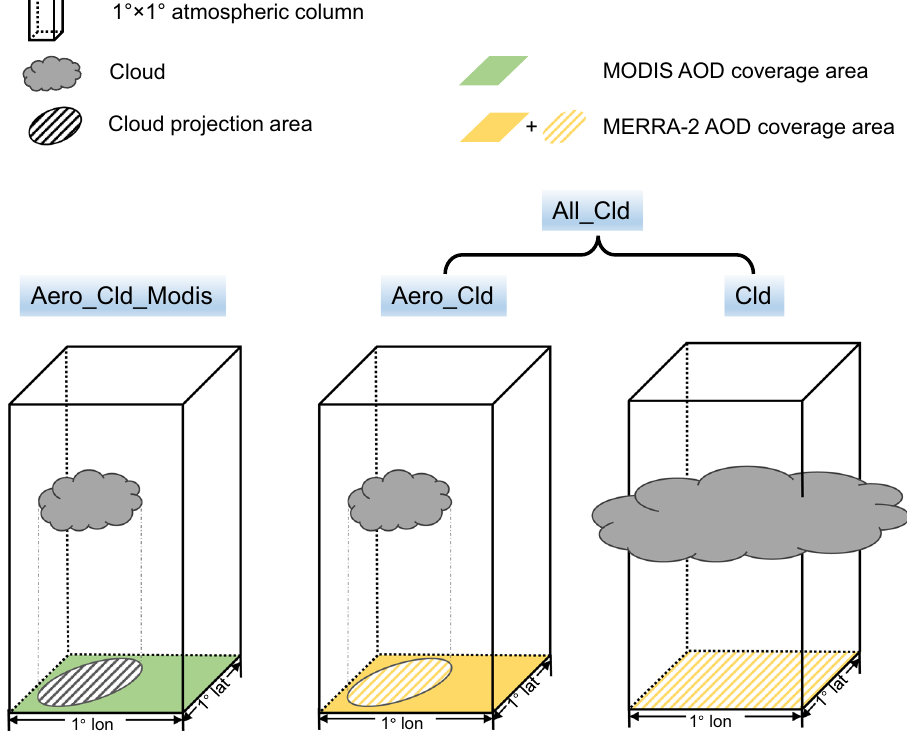
Fig. 1 Schematic diagram of four basic scenarios in this study. The schematic shows the combinations of clouds and its associated aerosol retrieval (green; MODIS aerosol optical depth (AOD))/reanalysis (yellow; MERRA-2 AOD) within 1° × 1° atmospheric column (cuboid) for different scenarios. Aero_Cld_Modis represents the combination of the clouds not fully covering 1° × 1° area and its adjacent MODIS aerosol retrieval. Aero_Cld includes the same cloud samples as Aero_Cld_Modis but utilizing MERRA-2 AOD. Cld scenario involves the clouds fully covering 1° × 1° area, i.e., no successful AOD retrieval so that one has to fi ll with re-analyzed AOD. All_Cld employs the combined datasets in Aero_Cld and Cld, including all available ambient clouds.